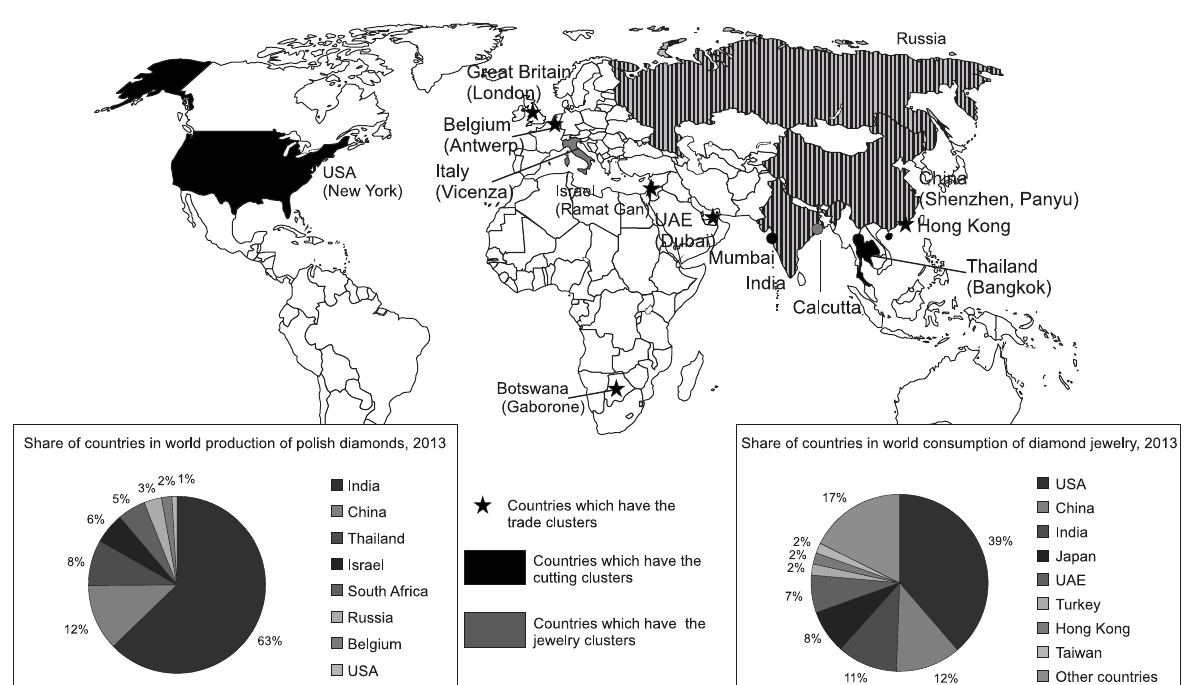
Fig. 3. Types of clusters of diamond complex (compiled by the